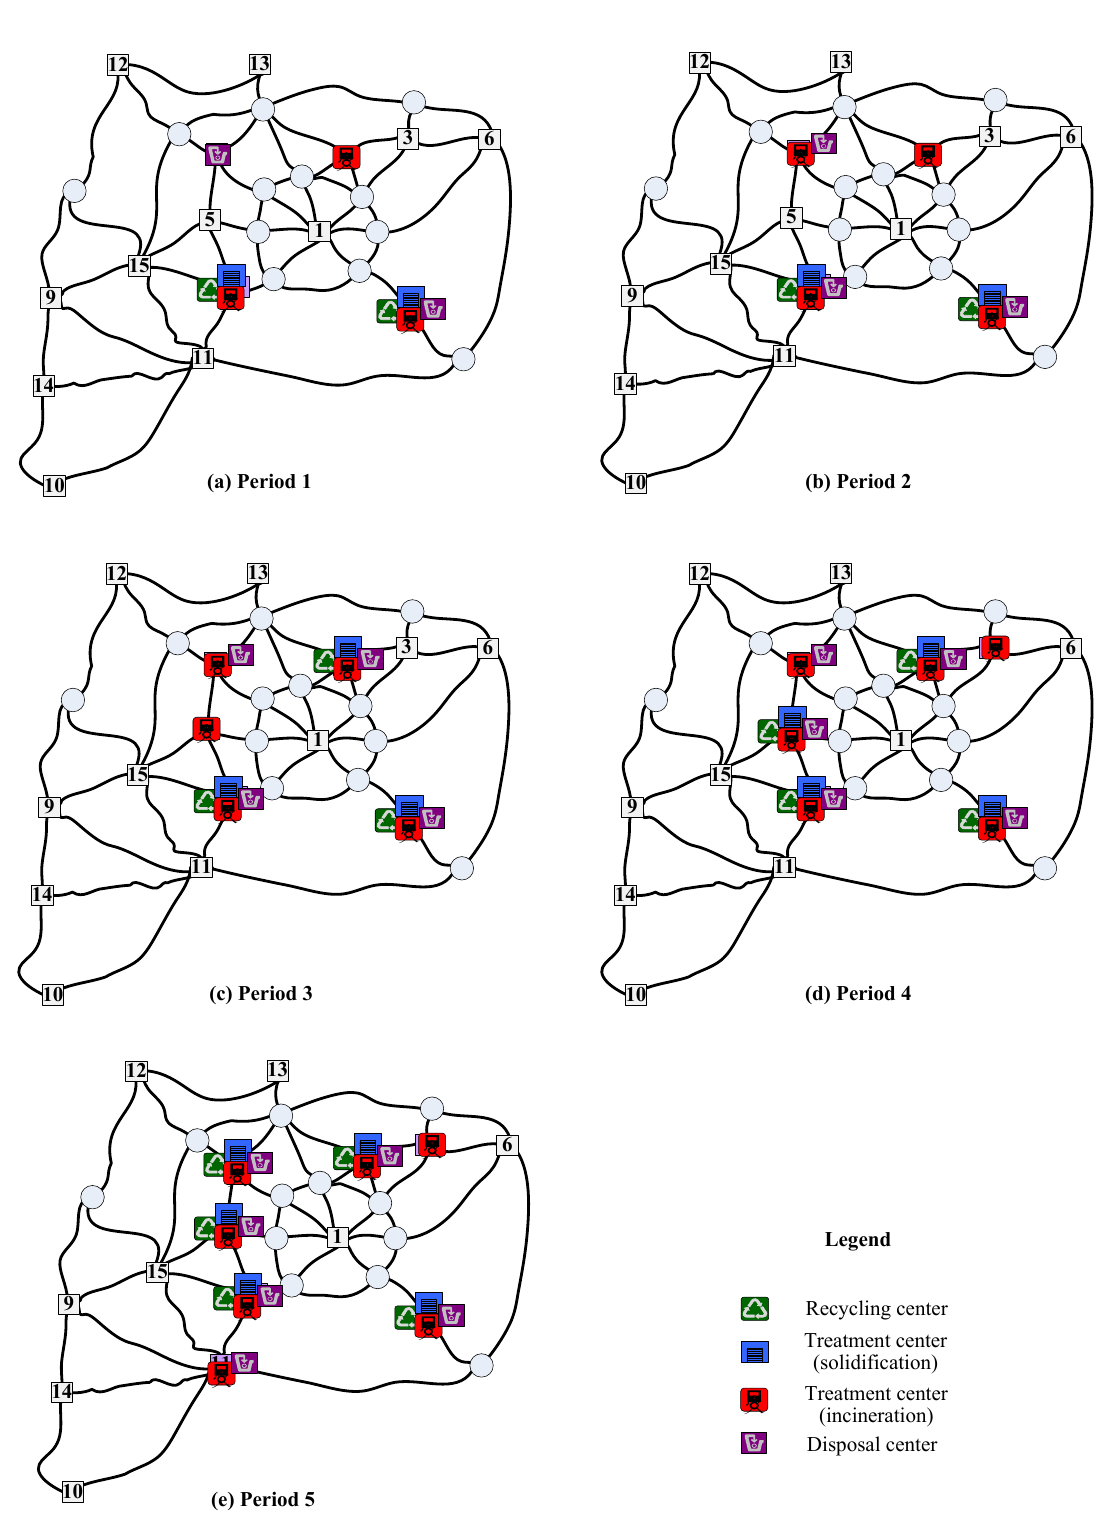
Figure 6. Location in non-dominated solution 1 (minimal total